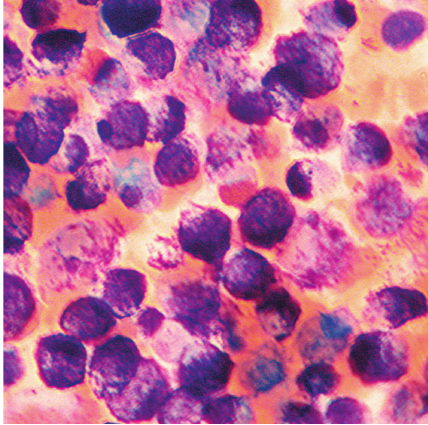
Figure 2: Infiltration with mast cells in bone marrow aspiration (original magnification ×